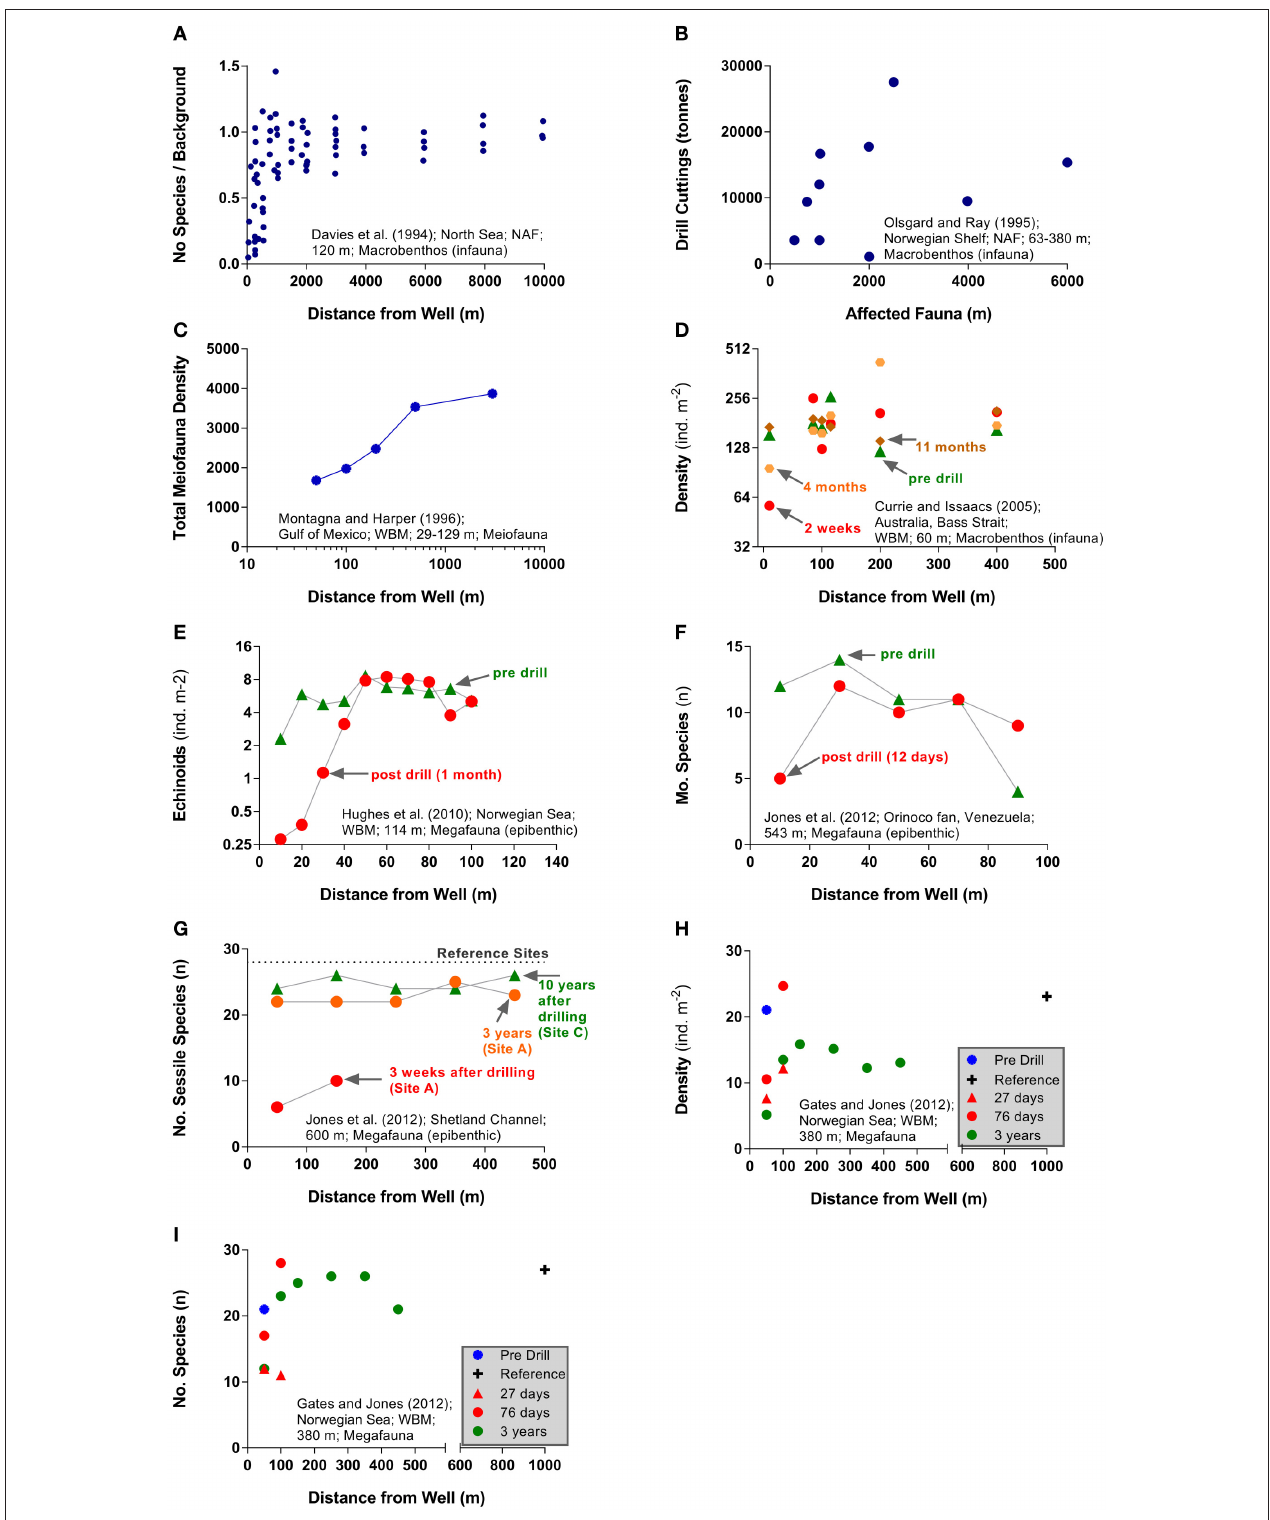
FIGURE 4 | Illustrative examples of spatial patterns in the benthos associated with exploratory and routine drilling operations (i.e., excluding large accidental spills; see Table 3 for additional information on graphed studies). Note that impacts in (A,B) are from oil-based drilling muds, and impacts in (F) are from a site where no drilling lubricant was used, while the rest of the studies (C–E,G–I) were from sites using water-based muds.